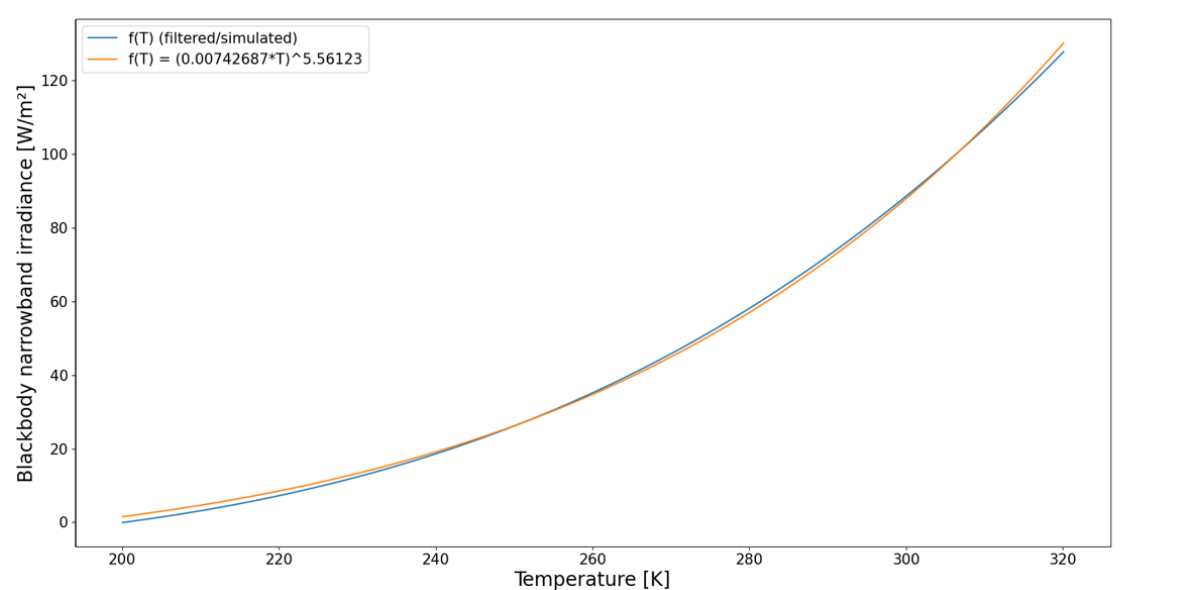
Figure 10. Blackbody narrowband irradiance as function of the blackbody temperature: blue curve = f(T) (fil- tered/simulated), orange curve = analytical fit.